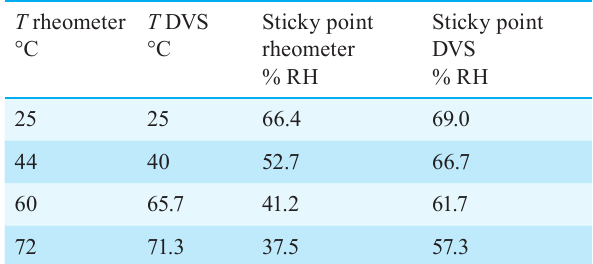
Table 2 Sticky point values for citric acid monohydrate recorded via the DVS using the curve fitting method and powder rheometer methodology in the tempera- ture range of 25–72